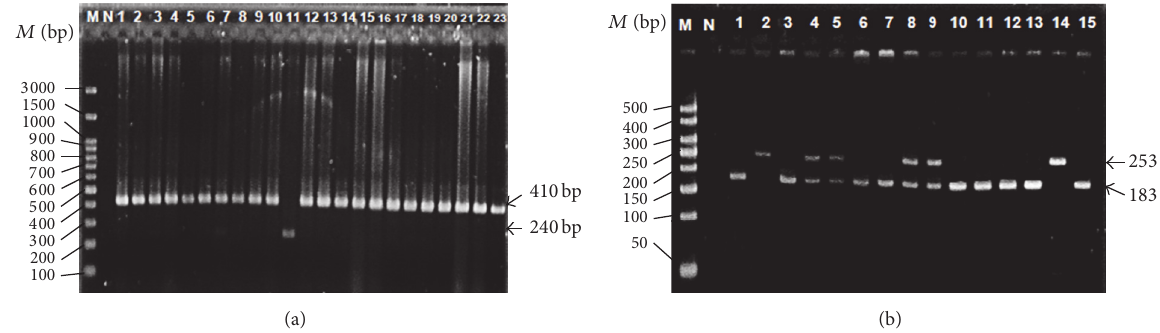
Figure 1: Images of PCR products of (a) IL1RA and (b) IL4 VNTR in 1.5% or 3.0% agarose gel, respectively. Lane M: 100bp or 50 bp DNA ladder (Thermo Fischer Scientific, MA, USA). Lane N: Negative Control. Lanes A1–6: 410/410bp (I/I). Lane A7: 410/240 bp (I/II). Lane A11: 240/240 bp (II/II). Lanes B1 and 3: 183/183 bp (B1/B1). Lanes B2 and 14: 253/253 bp (B2/B2). Lanes B4 and 5: 253/183 bp (B1/B2).